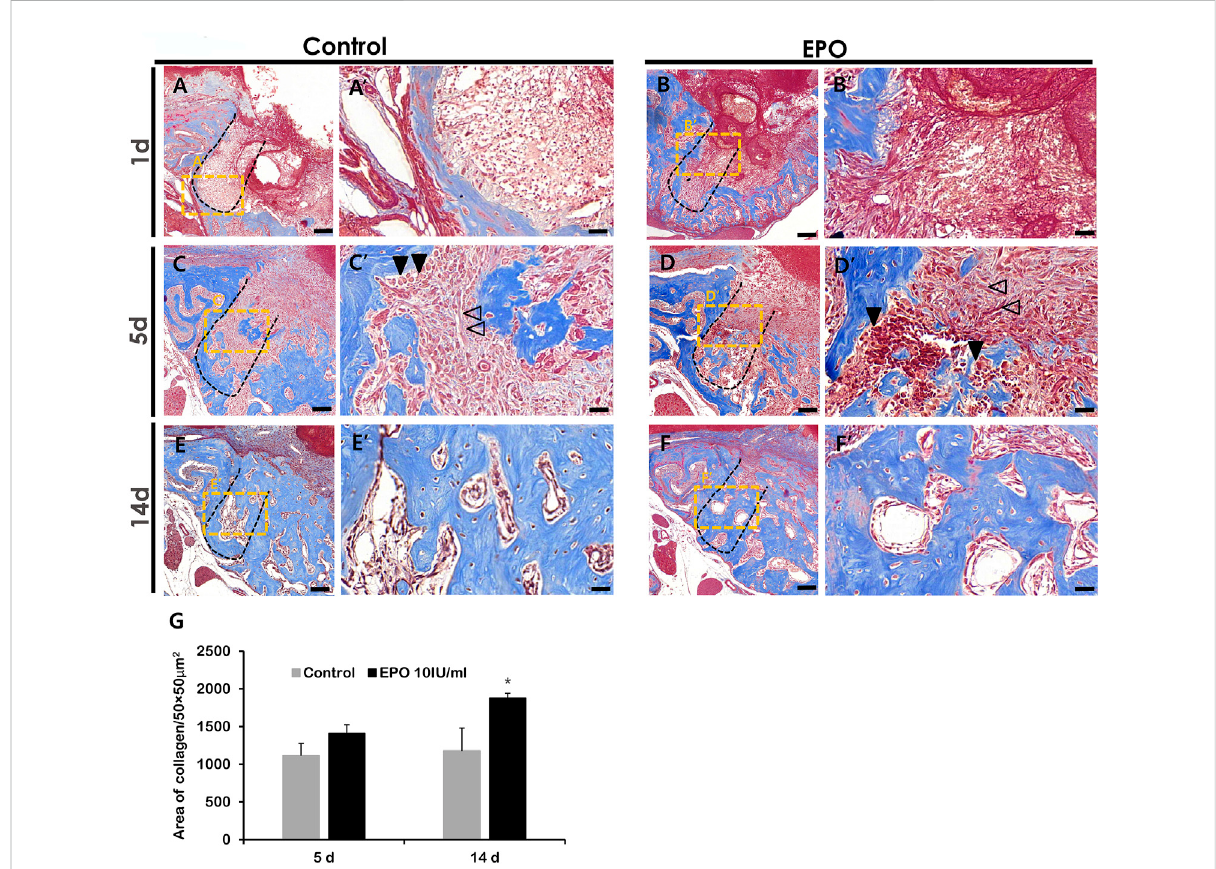
FIGURE 3 RepresentativephotomicrographsofalveolartissuesectionsstainedwithMasson ’ strichrome(MTC)inthecontrolgroup (A,C,E) andEPOgroup (B,D,F) at 1, 5 and 14 days. On day 1, residual hPDLF is observed in the socket walls in both groups, with more vascular structures visible in the experimentalgroup (A 9 ,B 9 ) .Onday5,earlysignsofnewboneformationare moreobviousintheexperimentalgroup compared tothecontrol group (C 9 ,D 9 ) .Onday14,bothgroupsshowmaturebone (E 9 ,F 9 ) ,buttheexperimentalgroupshowmorenewlyformedboneinthetoothsocket (E 9 ,F 9 ) . The volume of newly synthesized collagen (blue) is less in the control group (C,E) than in EPO group (D,F) . Statistical analysis for newly synthesized collagen in the tooth socket (G) . Black arrow heads point to osteoblasts, and transparent arrows to fi broblast-like cells. Scale bar: X = 100 μ m, X ’ = 20 μ m (X ′ is a higher magni fi cation of X). *Statistically signi fi cant differences compared to the untreated control ( p <